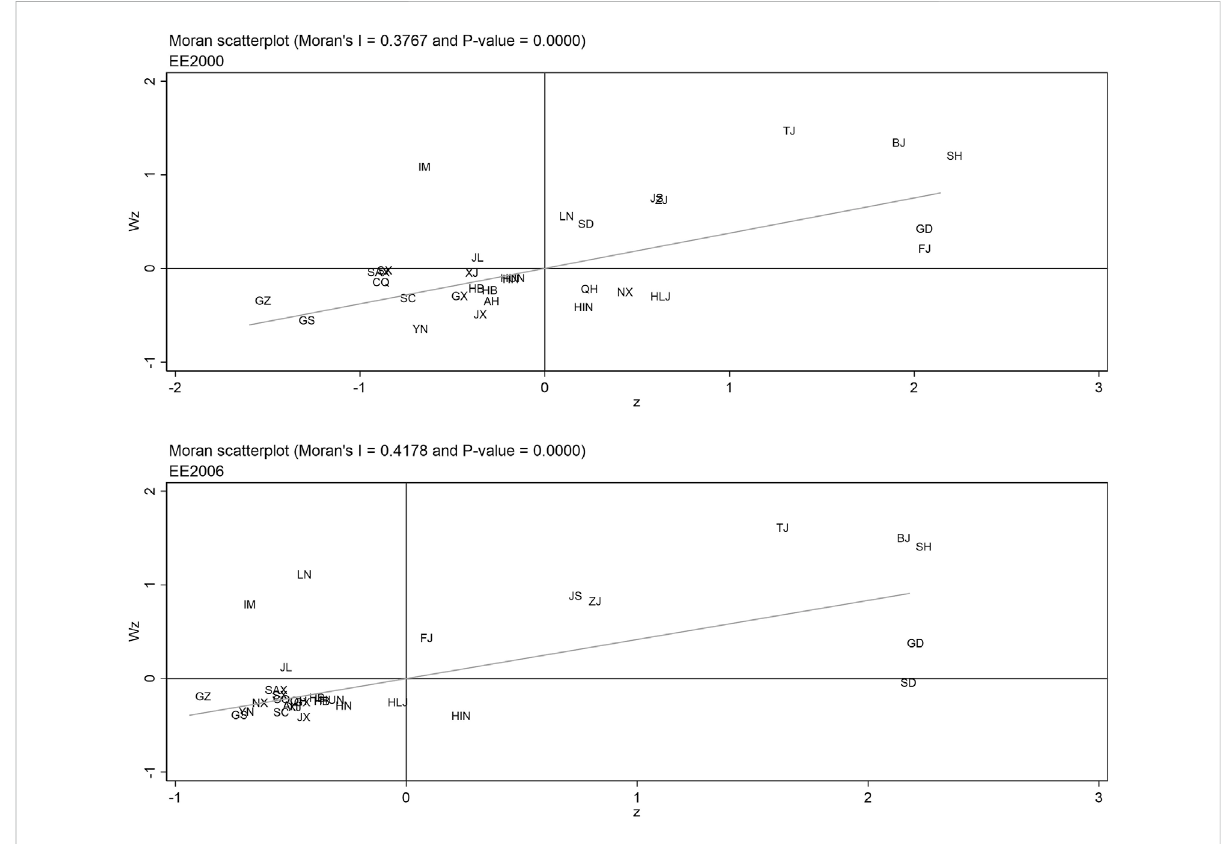
FIGURE 2 Moran scatter plot of eco-ef fi ciency in China in 2000 and